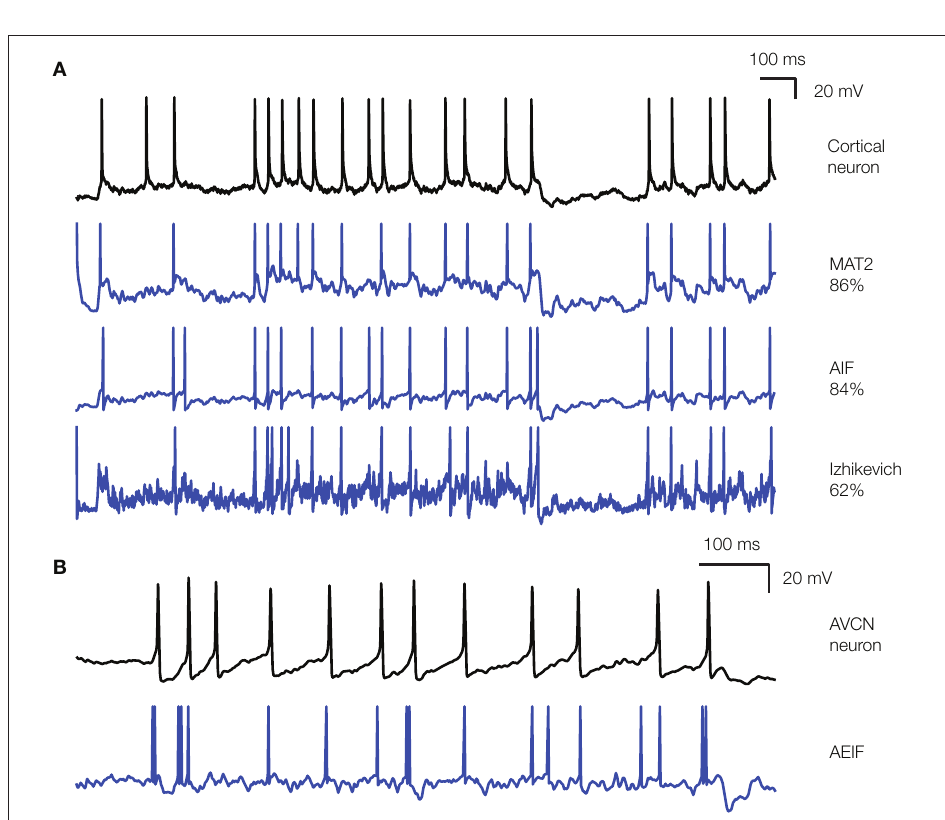
Figure 4 | Fitting spiking models to electrophysiological recordings. (A) The response of a cortical pyramidal cell to a fluctuating current (from the INCF competition) is fitted to various models: MAT (Kobayashi et al., 2009), adaptive integrate-and-fire, and Izhikevich (2003). Performance on the training data is indicated on the right as the gamma factor (close to the proportion of predicted spikes), relative to the intrinsic gamma factor of the neuron (i.e., proportion of common spikes between two trials). Note that the voltage units for the models are irrelevant (only spike trains are fitted). (B) The response of an anteroventral cochlear nucleus neuron (brain slice made from a P12 mouse, see Methods in Magnusson et al., 2008) to the same fluctuating current is fitted to an adaptive exponential integrate-and-fire [Brette and Gerstner, 2005; note that the responses do not correspond to the same portion of the current as in (A) ]. The cell was electrophysiologically characterized as a stellate cell (Fujino and Oertel, 2001). The performance was Γ = 0.39 in this case (trial-to-trial variability was not available for this recording).